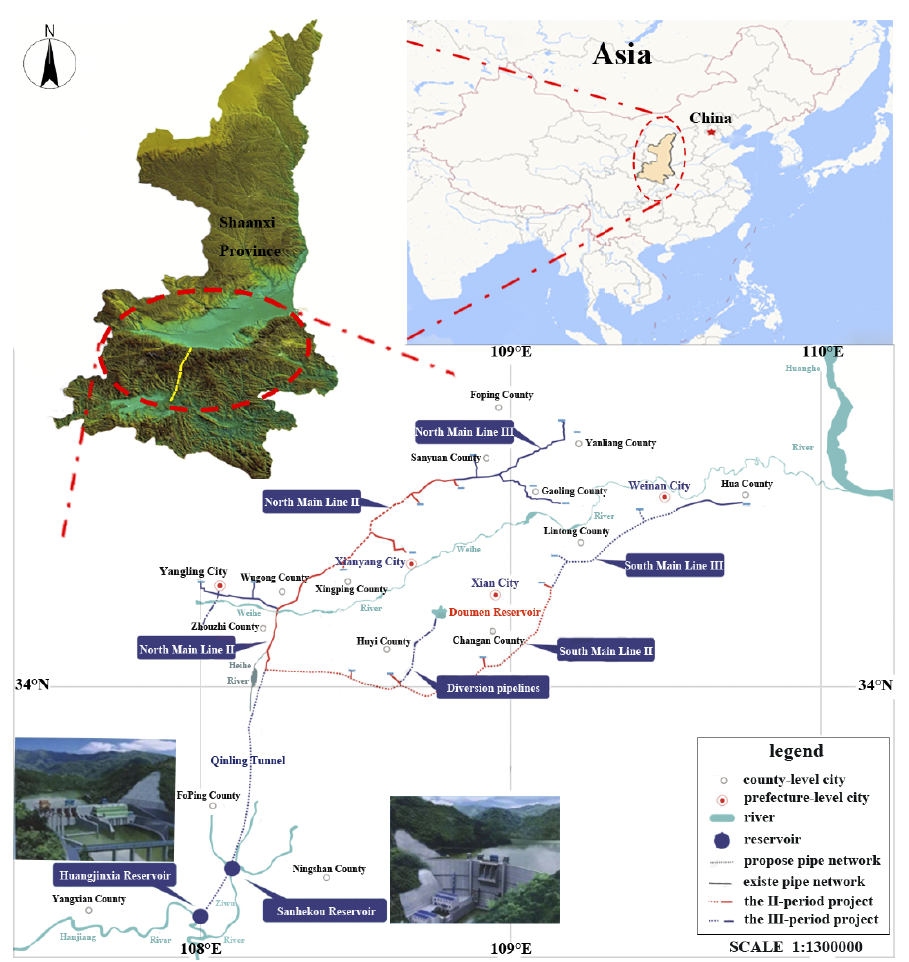
Figure 1. Layout of Hanjiang-to-Weihe River Water Diversion (HWWD) Project.